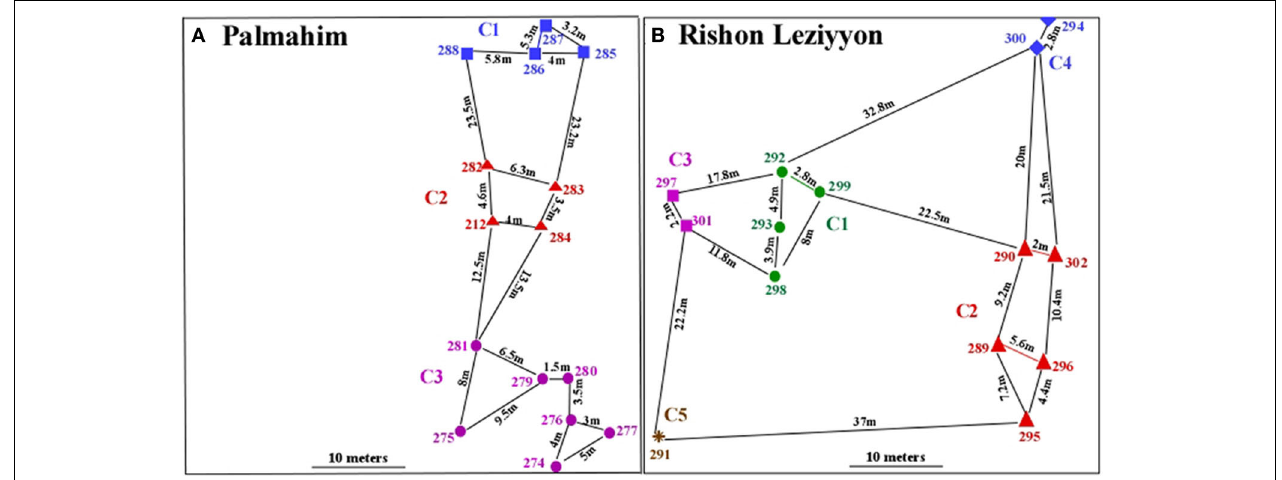
FIGURE 1 | Spatial distribution of nests at the Palmahim (A) and Rishon Leziyyon (B) sites. Each nest is represented by a number (e.g., 285; 286 etc.) and each genetic colony is represented by a different symbol, color and number (e.g., C1; C2 etc.).